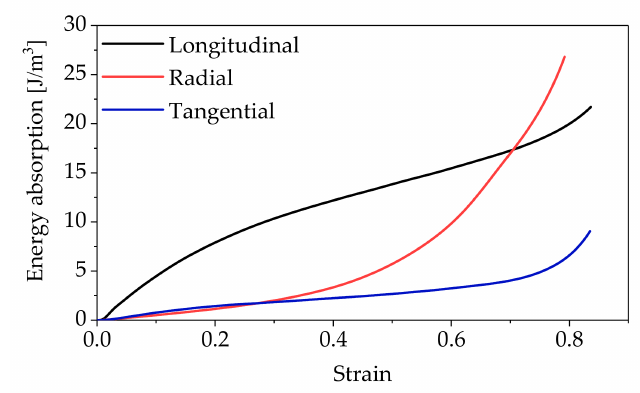
Figure 6. The energy dissipation–strain